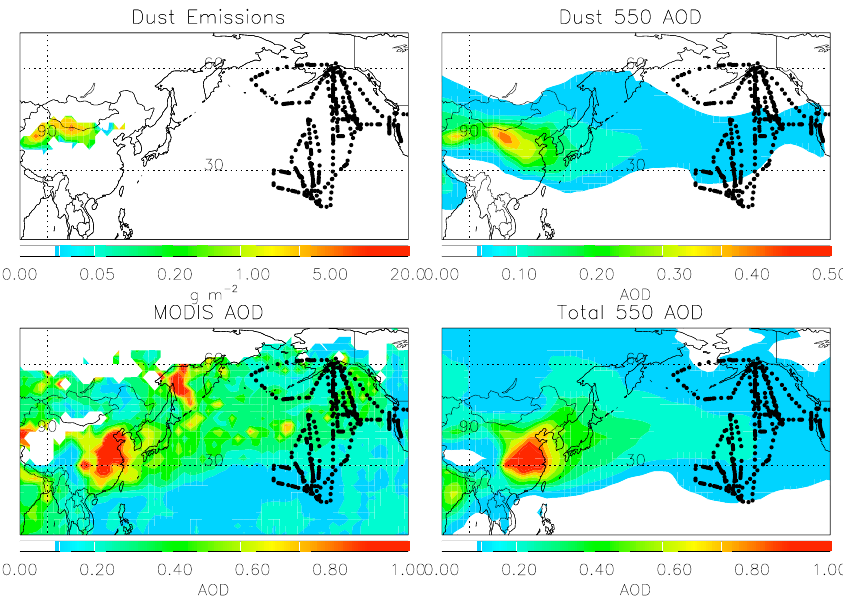
Fig. 2. Model distributions of dust emission (units: gm − 2 ) , 550nm dust aerosol optical depth (AOD), and total 550nm AOD for the INTEX- B period of 21 April–11 May 2006. The lower left panel shows the observed MODIS 550nm AOD (Collection 5, Terra and Aqua satellites) for the same period. INTEX-B flight tracks are shown in black, with individual symbols denoting the aerosol samples used in this work.